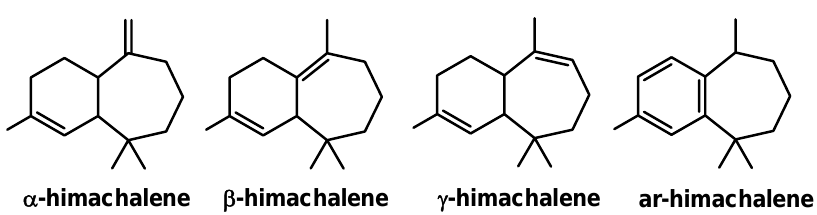
Figure 1. Main components of cedarwood